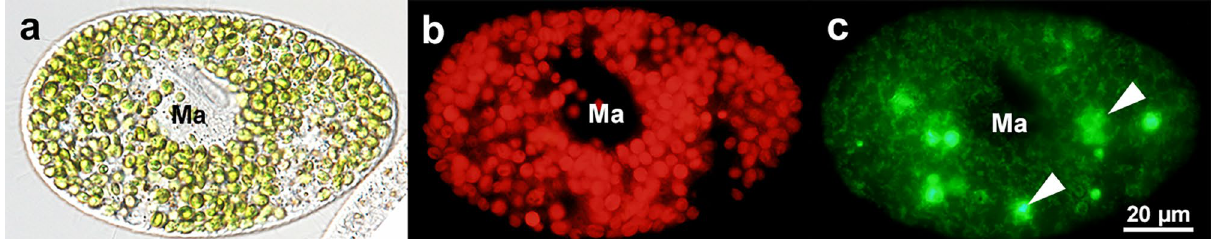
Figure 4. Photomicrographs of algae-bearing P. bursaria strain Yad1g1N cell with MitoTracker Green. ( a ) DIC micrograph. ( b ) Autofluorescence micrograph of chlorophyll in algal chloroplasts. ( c ) Fluorescence of MitoTracker Green. Host mitochondria appear to be surrounded symbiotic algae. Note that the fluorescence of MitoTracker Green is also observed in the host DVs ( c , arrowhead). Ma, macronucleus. Bar = 20 μm.